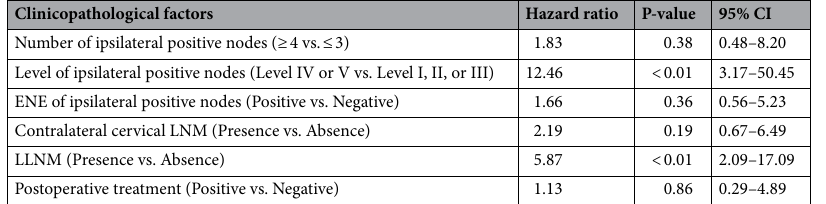
Table 3. Multivariate analyses of factors related to 5-year disease-specific survival in tongue SCC patients with lymph node metastasis. Analyses performed using Cox proportional hazards model. SCC squamous cell carcinoma, CI confidence interval, LNM lymph node metastasis, LLNM lingual lymph node metastasis, ENE extranodal extension. P < 0.05 is considered statistically